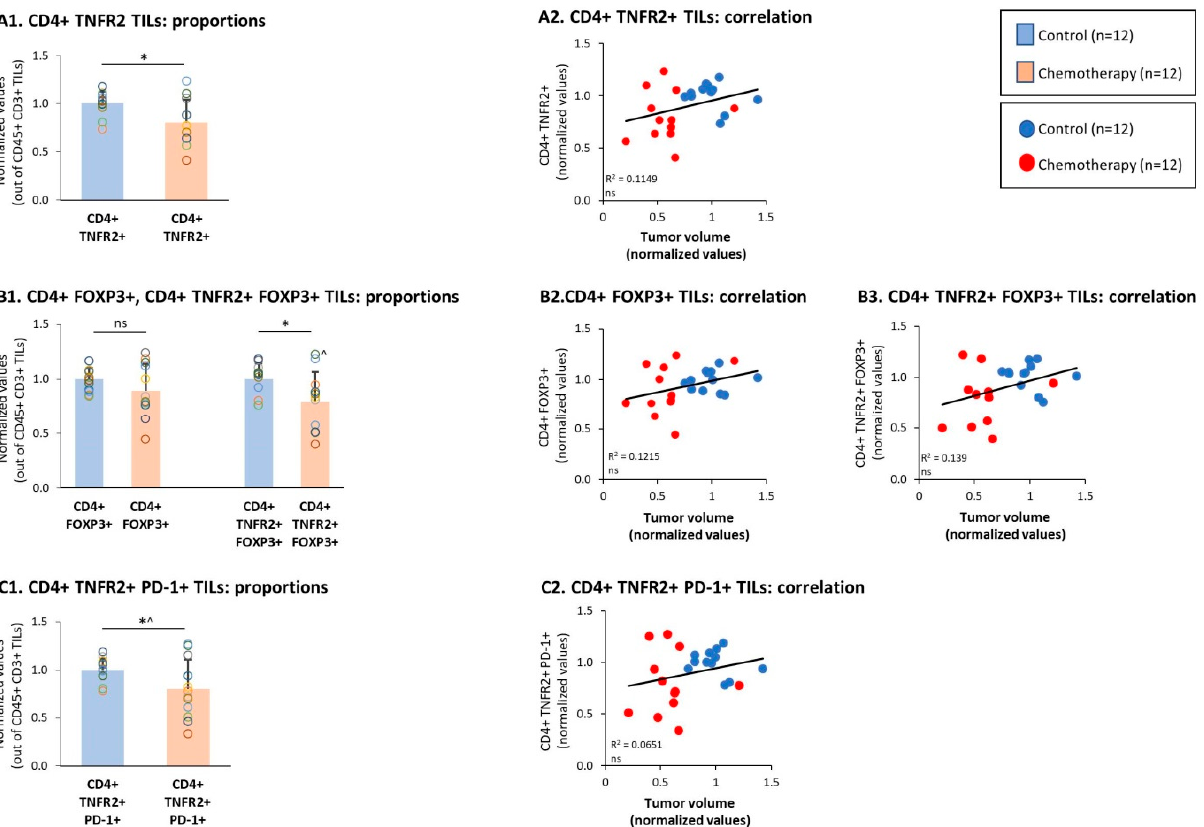
Figure 4. Chemotherapy reduced the proportions of CD4+ TNFR2+ FOXP3+ and CD4+ TNFR2+ PD-1+ TILs. Murine 4T1 TNBC cells were syngrafted to BALB/c mice in the presence of chemotherapy or a vehicle control; procedures and analyses were performed as described in Figure 3. ( A ) CD4+ TNFR2+ TILs, gated out of CD45+ CD3+ cells. ( A1 ) Proportions of CD4+ TNFR2+ TILs. ( A2 ) CD4+ TNFR2+ TILs, correlated with tumor volumes. ( B ) CD4+ FOXP3+ and CD4+ TNFR2+ FOXP3+ TILs, gated out of the CD45+ CD3+ cells. ( B1 ) Proportions of CD4+ FOXP3+ and CD4+ TNFR2+ FOXP3+ TILs. ( B2 , B3 ) CD4+ FOXP3+ and CD4+ TNFR2+ FOXP3+ TILs, respectively, correlated with tumor volumes. In B1: ˆ n = 11. ( C ) CD4+ TNFR2+ PD-1+ TILs, gated out of CD45+ CD3+ cells. ( C1 ) Proportions of CD4+ TNFR2+ PD-1+ TILs. ( C2 ) CD4+ TNFR2+ PD-1+ TILs, correlated with tumor volumes. In the proportion and correlation analyses, the average value of the vehicle-treated group in each biological repeat was given the value of 1 and the values of all mice analyzed in that repeat were normalized accordingly. The value of each mouse is presented as a dot. * p < 0.05 (in C1: ˆ p = 0.0505), ns: not significant (two-tailed unpaired Student’s t -test; correlation analyses: Pearson;